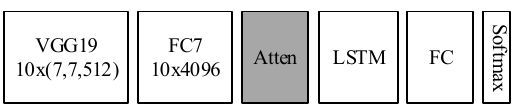
Figure 6. The visualization processes of feature extraction.